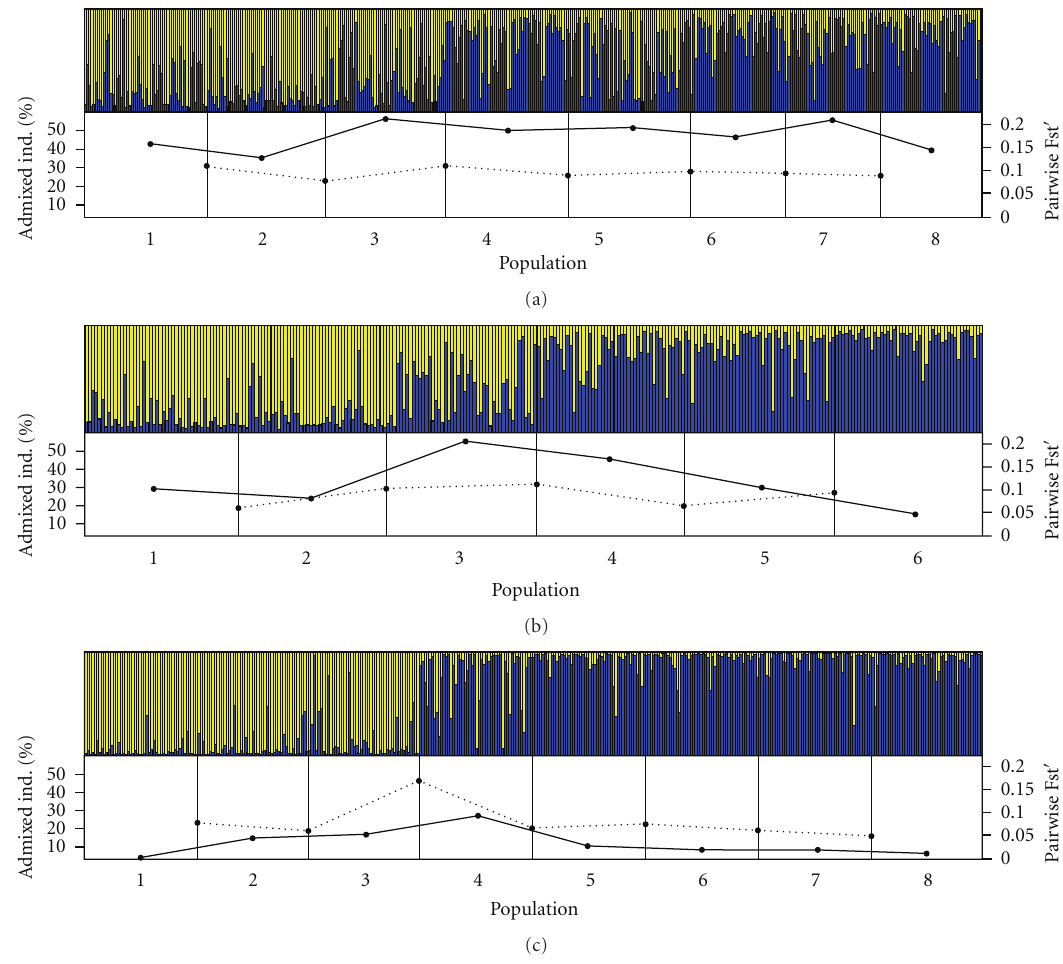
Figure 2: Population structure and admixture rates along the three transects. Solid lines represent admixture rates, and broken lines represent pairwise Fst values.